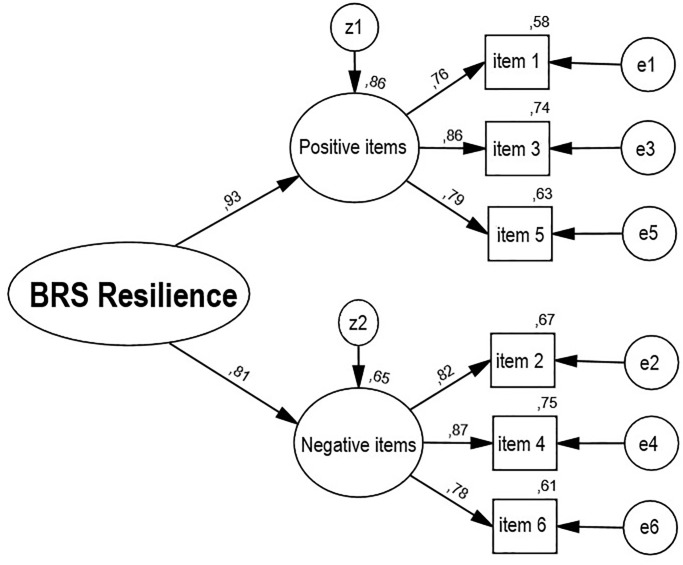
Factor analysis of the BRS.